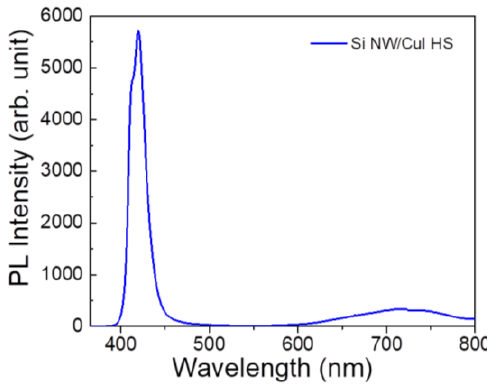
Figure 6. Room temperature photoluminescence spectrum of Si NWs/CuI embedded heterostructure acquired at the excitation wavelength of 364 nm.